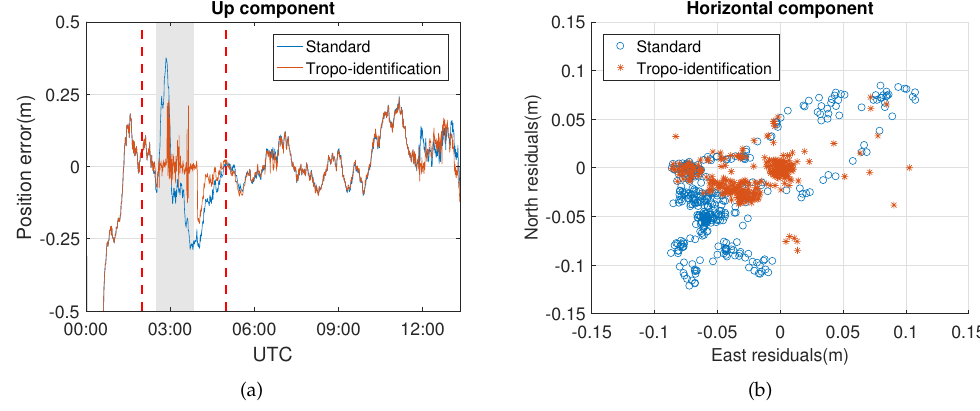
Figure 8. ( a ) Residuals of the up component and ( b ) the horizontal component during Event 2.